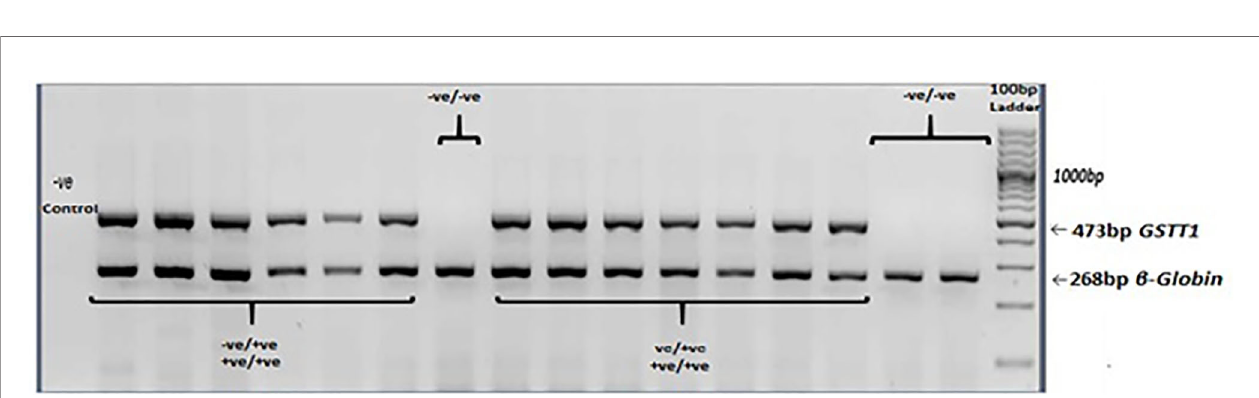
FIGURE 3 | GSTT1 genotyping. Agarose gel electrophoresis (2%) of multiplex PCR ampli fi ed products: GSTT1 -absent ( – ve/-ve) genotype did not show ampli fi cation of a 473bp fragment. b -globin gene was included as an ampli fi cation control.